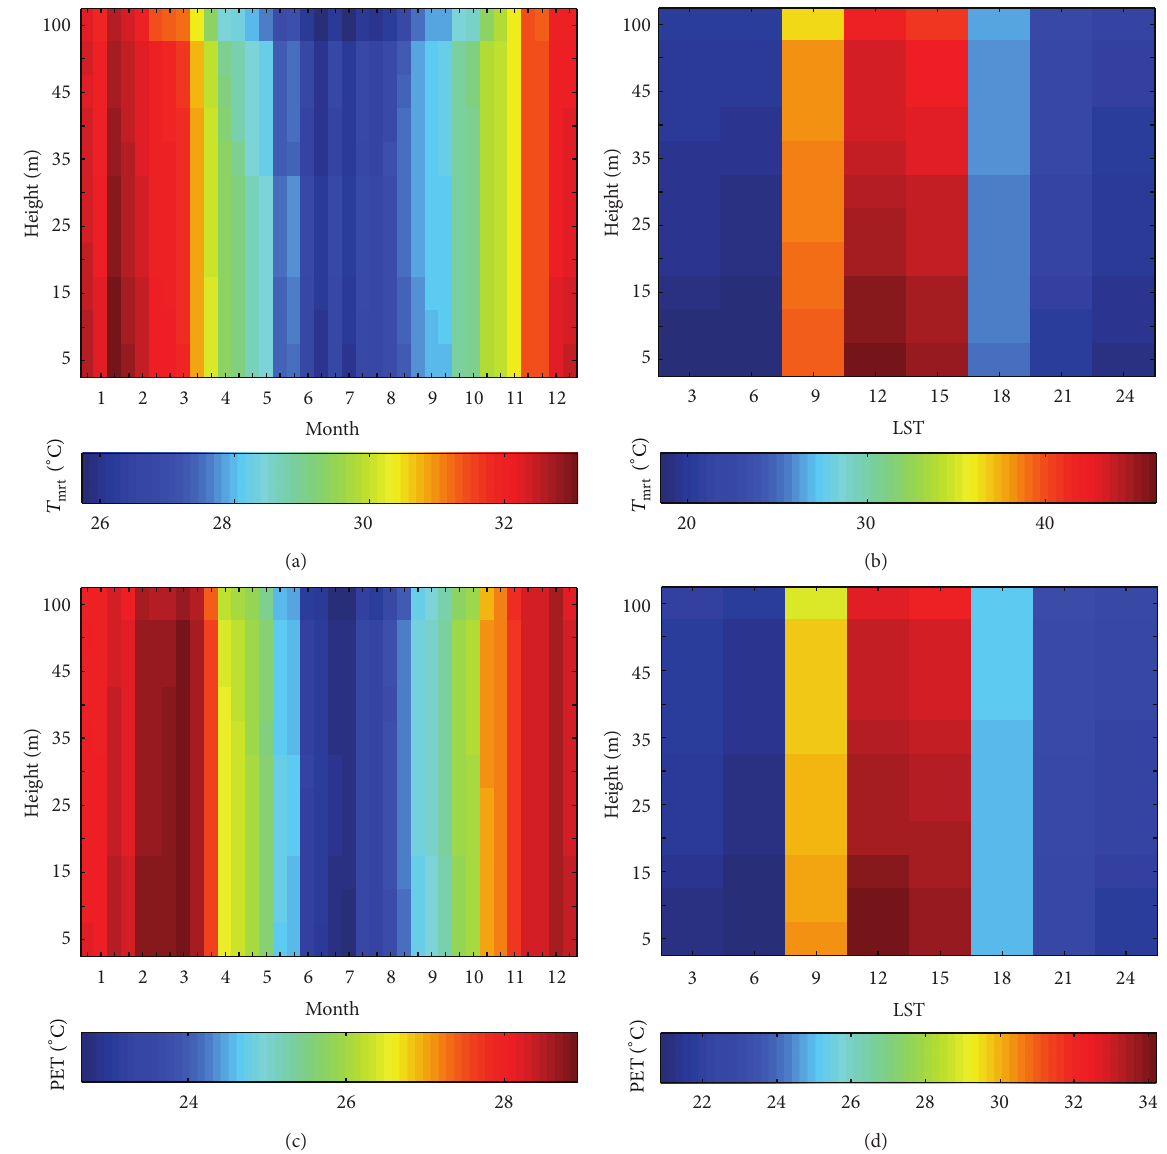
Figure 8: Effects of increasing buildings’ height on the temporal distribution of 𝑇 cycle (a) and diurnal cycle (b). The corresponding thermal comfort distribution is shown in terms of PET index ((c) and